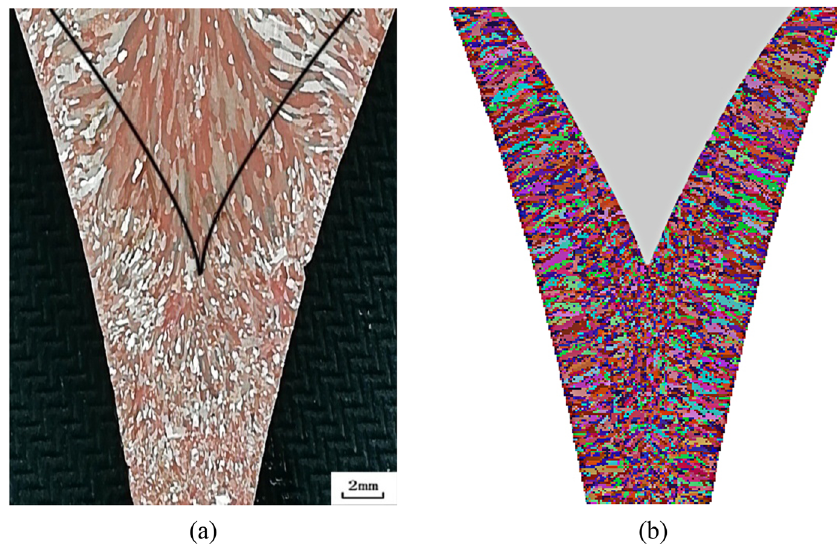
Figure 2: Solidi fi cation structure and simulation results of T2 copper molten pool area. ( a ) T2 copper solidi fi cation structure and ( b ) simulation results of T2